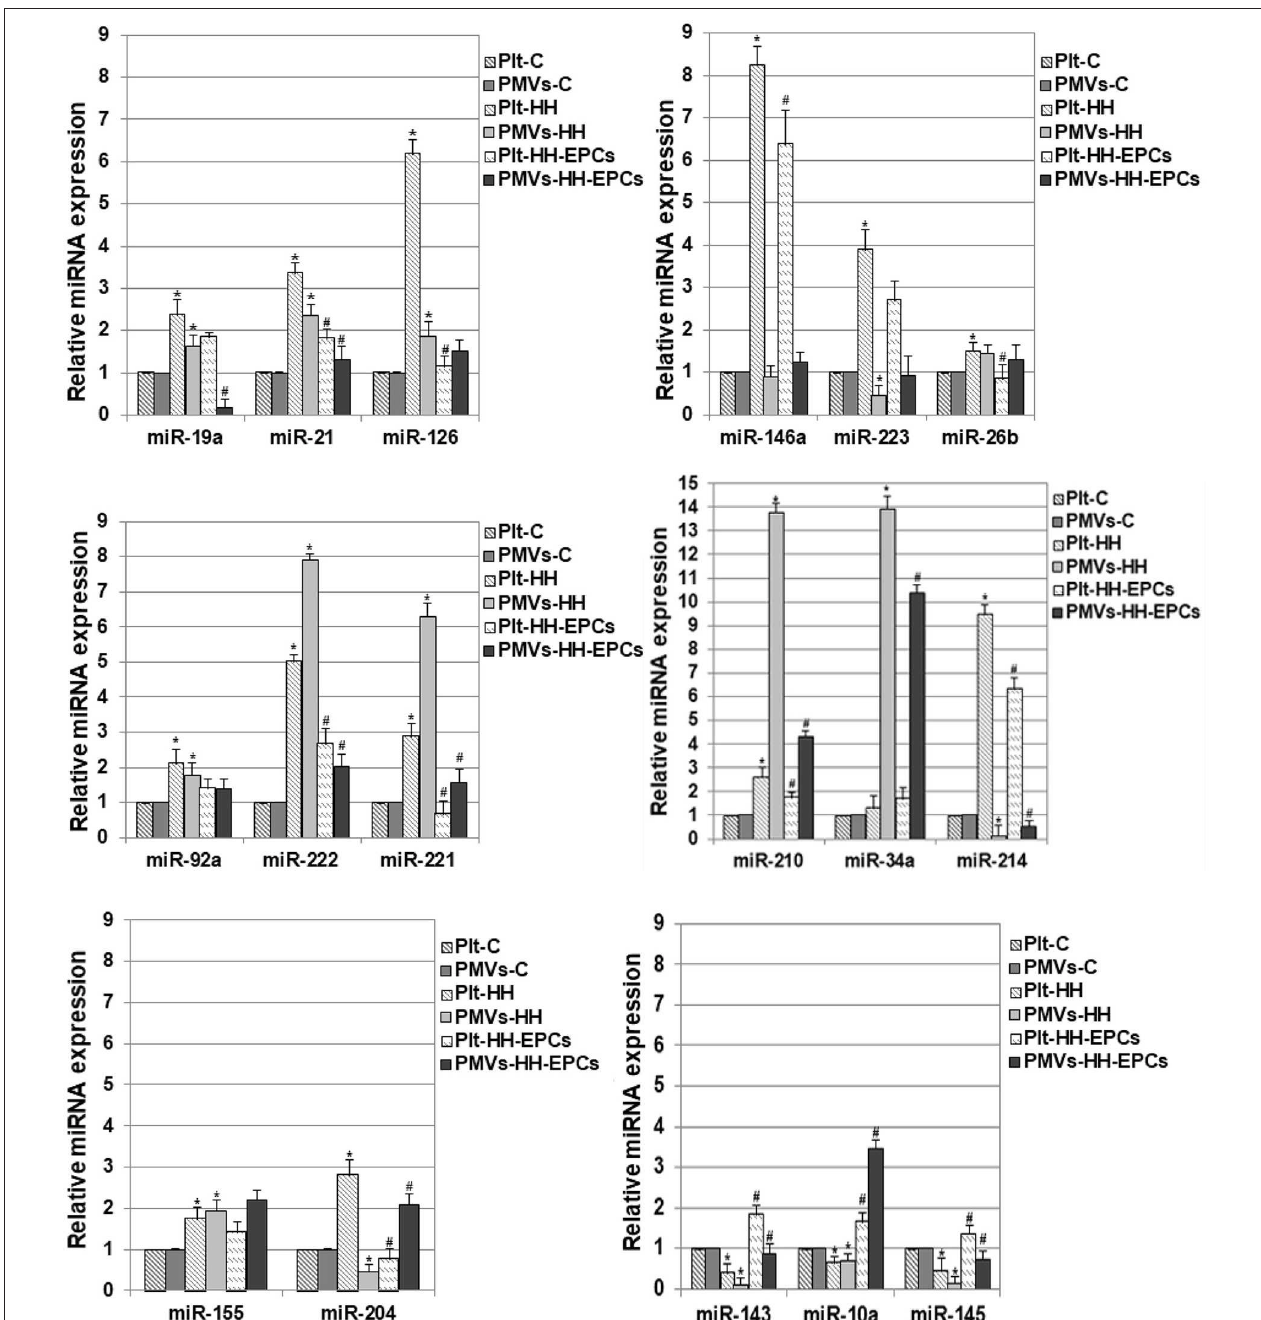
FIGURE 2 | Relative expression levels of 17 differentially expressed miRNAs in platelets (Plt) and platelet-derivate microvesicles (PMVs) obtained from hamster groups: control (Plt-C and PMVs-C), hypertensive-hyperlipidemic (Plt-HH and PMVs-HH), HH treated with EPCs (Plt-HH-EPCs and PMVs-HH-EPCs). The statistically significant differences between the groups were calculated, and represented as * p ≤ 0.05 for values vs. C group, and as # p ≤ 0.05 for values vs. HH group (one way ANOVA analysis).